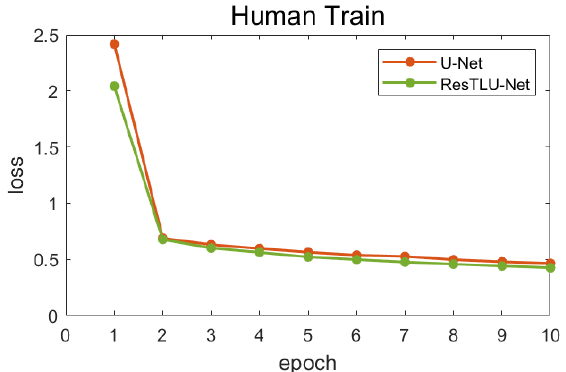
Figure 8. Line chart of training loss on human brain datasets (Dataset I).